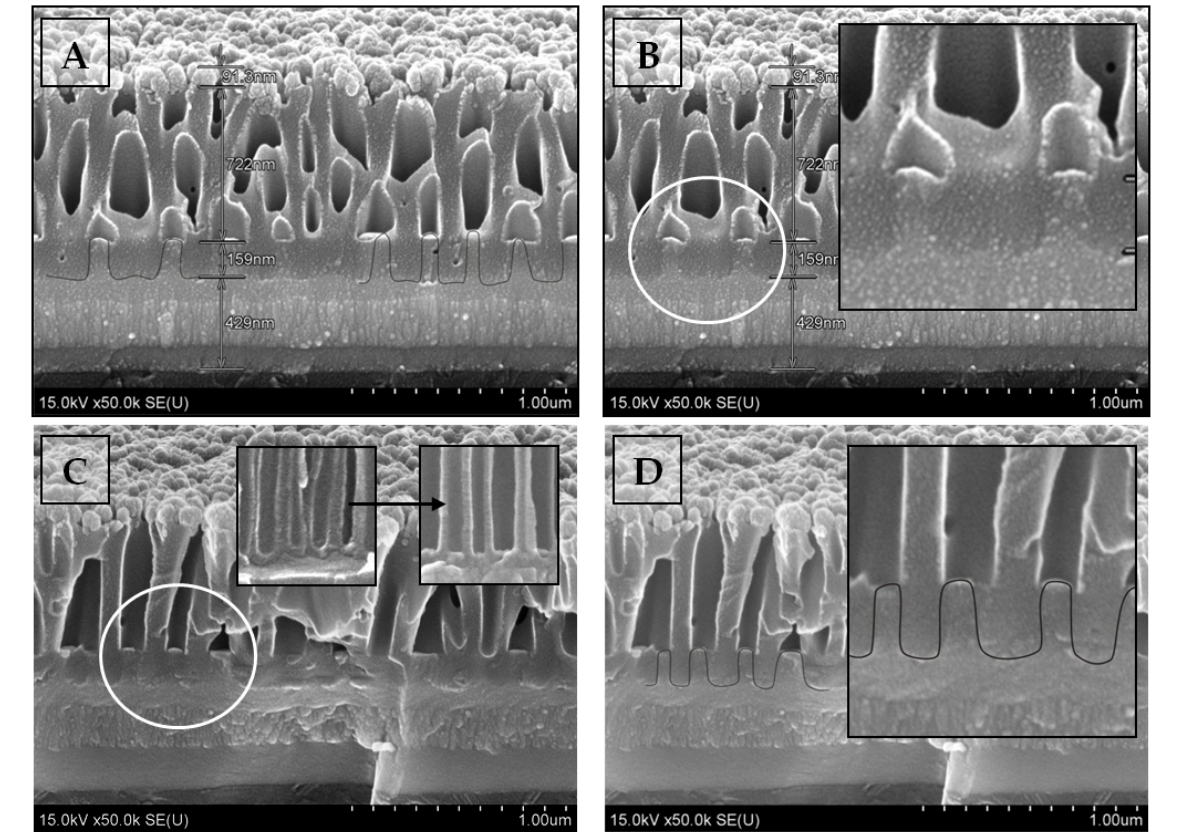
Figure 6. Cross ‐ section SEM images of sample 3 (Si/SiO 2 /Ta/Ta 2 O 5 /TPAA/Ni) after the first stage of double ‐ layer Al/Ta composition anodization and Ni deposition.